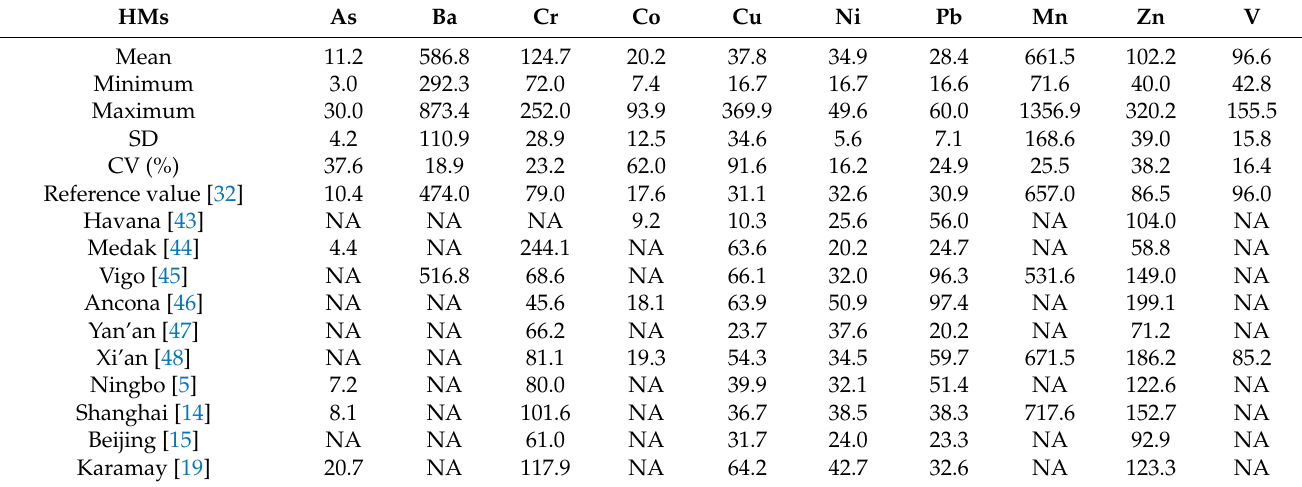
Table 1. The concentrations of HMs (mg kg − 1 ) in Mianyang urban area and other cities worldwide, as well as the reference values of Sichuan